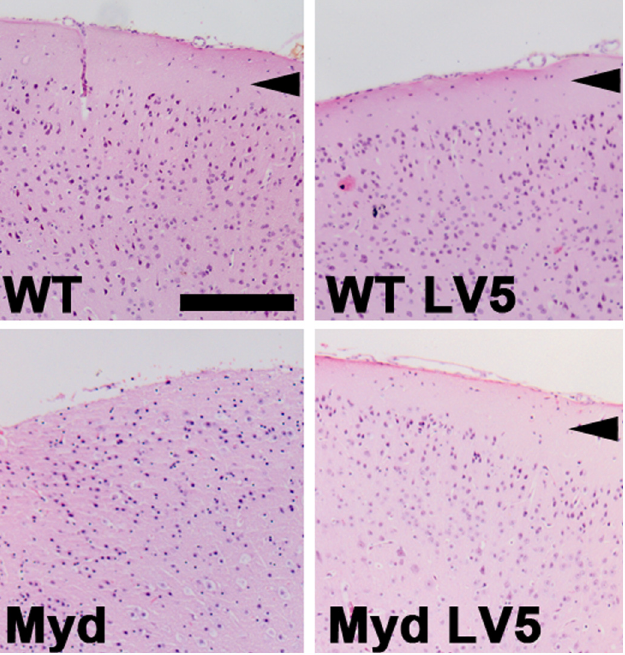
Fig 4. The LARGE-LV5 transgene corrects LARGE myd cortical defects. Haematoxylin/Eosin staining of cortical coronal sections of brains from wild type, WT-LV5, LARGE myd and LARGE myd -LV5 mice (as indicated). WT and WT-LV5 mice display normal laminar cortical arrangement, with a clear molecular layer which is lost in LARGE myd but restored by the LARGE-LV5 transgene (arrowheads). Bar: 200 μ